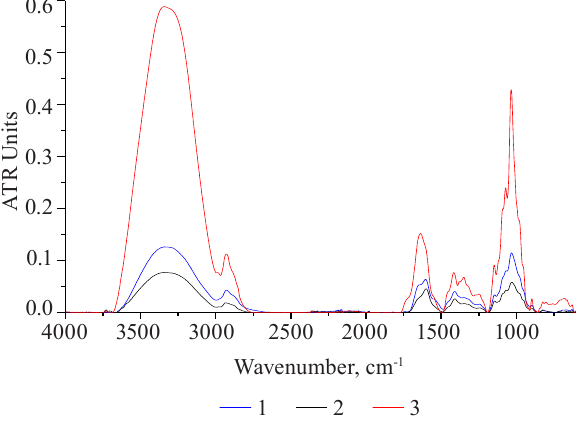
Figure 9 IR-spectra of the PS-complexes: (1) PS-complex of industrial flax seeds, (2) PS-complex of LM-98 seeds, (3) purified PS-complex obtained from sample E, Table 2